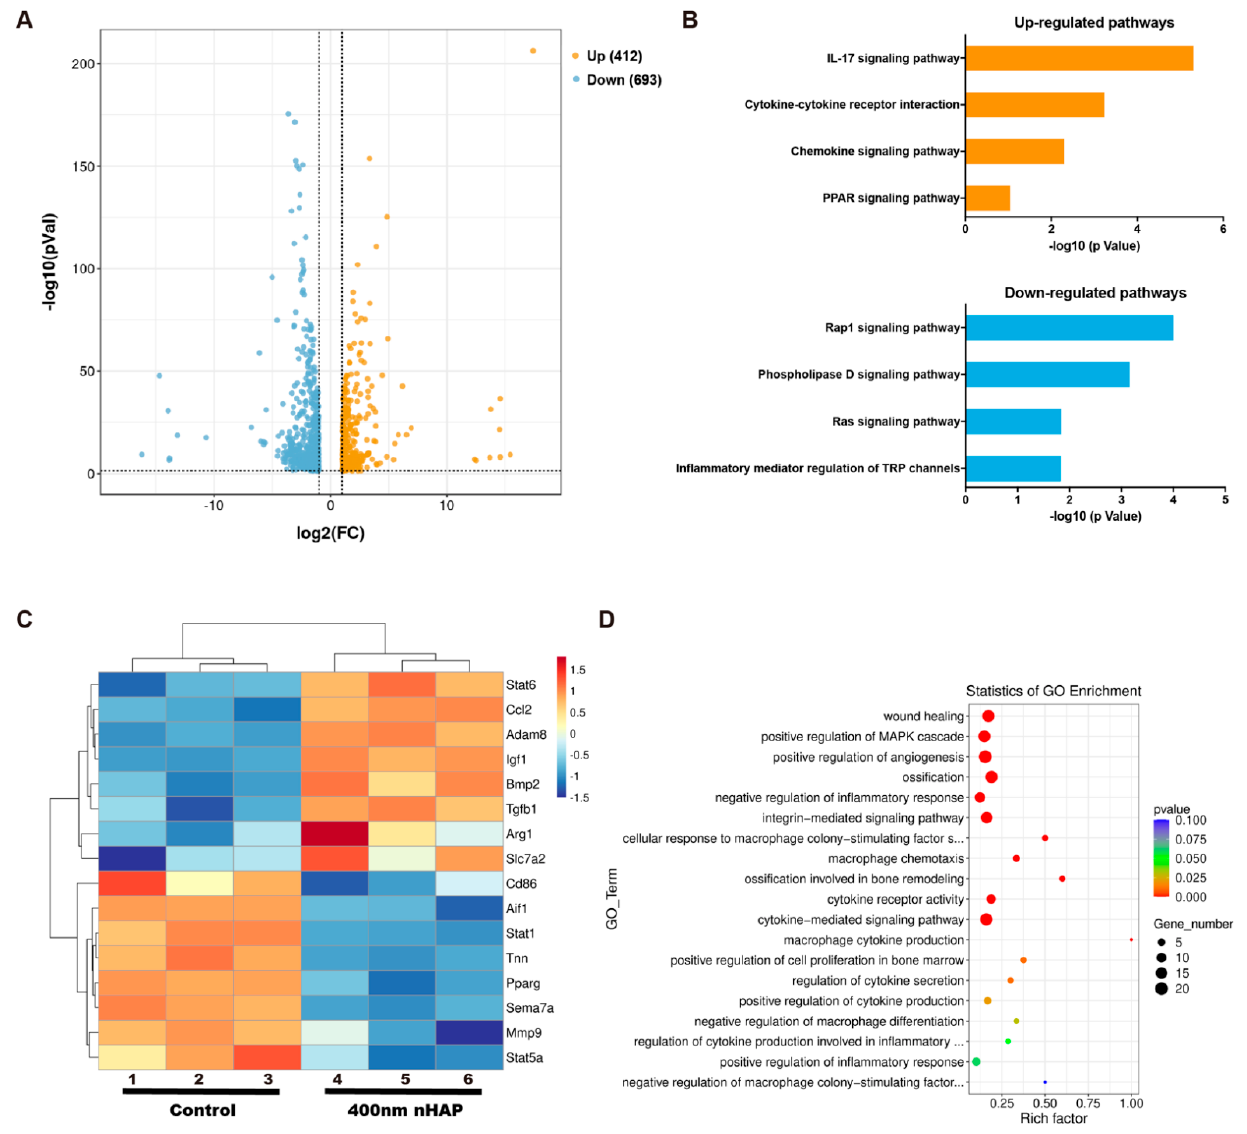
Figure 3. Gene expression analysis of macrophages cultured with nHAPs. ( A ) The volcano plot of differential expression of genes. ( B ) Representative top 4 upregulated and 4 downregulated pathways analyzed by KEGG pathway method. ( C ) Microarray heat map depicting the fold change in expression of selected genes. ( D ) Statistics of GO Enrichment.